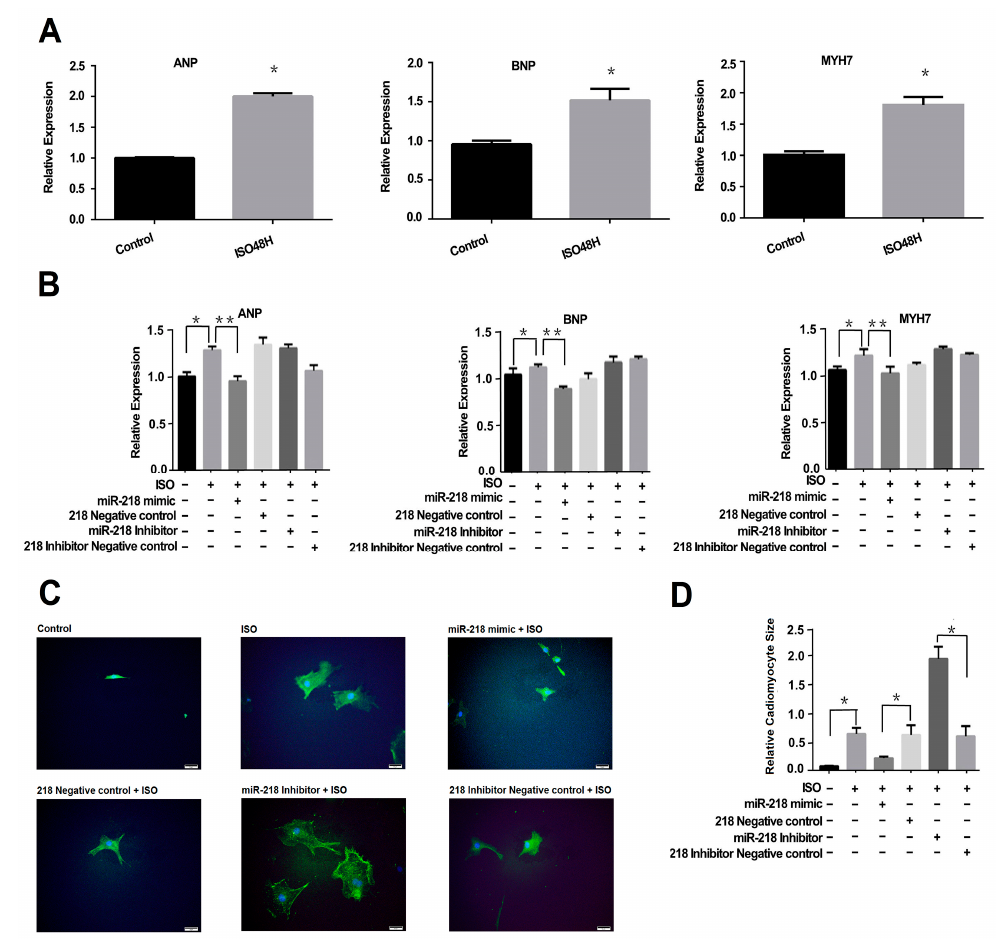
Figure 1. Effect of miR-218 on ISO-induced hypertrophy in cultured NRCMs. ( A ) the status of ANP , BNP and MYH7 levels was detected by real-time PCR in induced-hypertrophic cadiomyocytes; ( B ) the effect of miR-218 mimic on expression status of ANP , BNP and MYH7 in induced-hypertrophic cadiomyocytes; ( C ) the cell size change of cardiomyocytes in different conditions (Scale bar: 50 µm); and ( D ) mean cell size of α -actinin positive NRCMs. Fifty individual cells were analyzed per group. The data were displayed as the means ± SEM (* p < 0.05; ** p < 0.01).